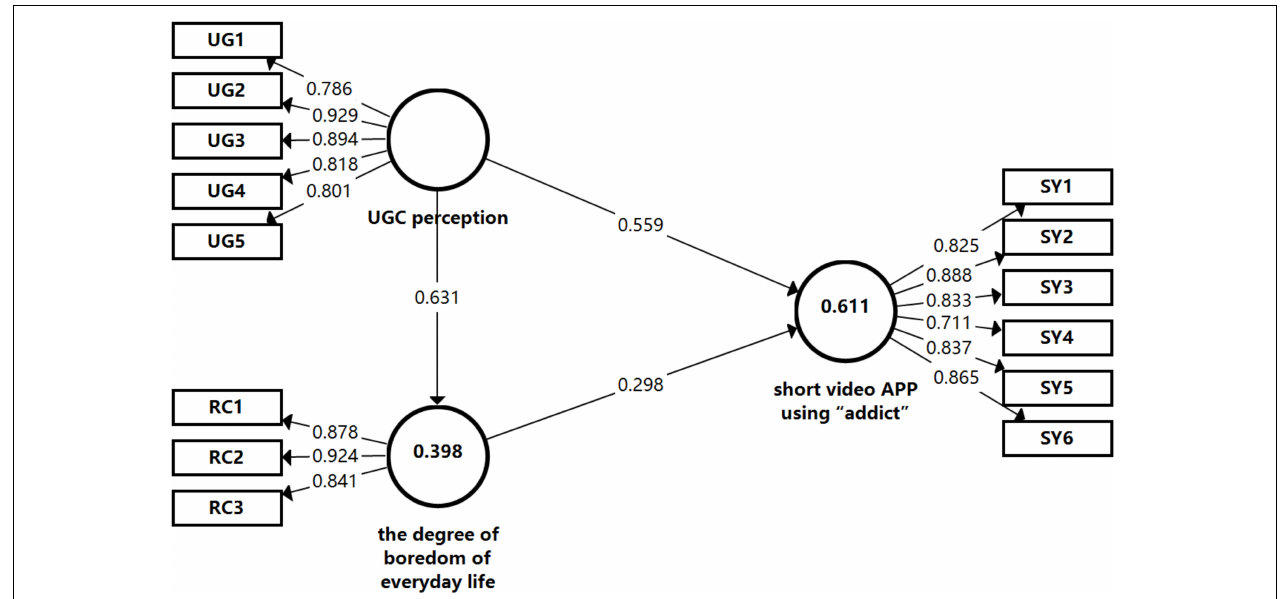
FIGURE 2 | Structural model of adolescent addiction to short video apps.